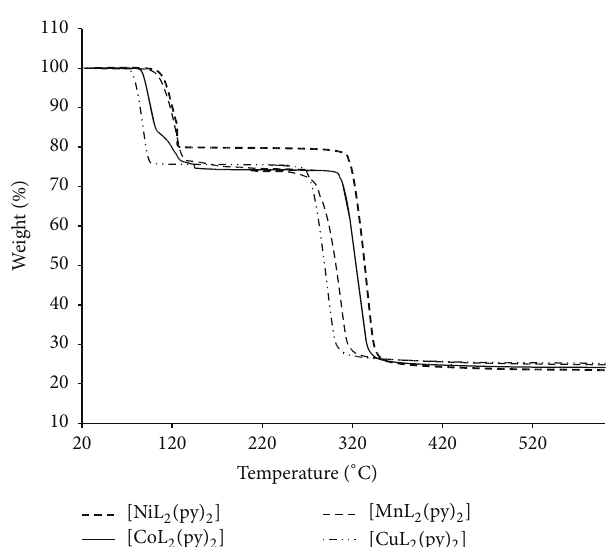
Figure 1: TGA graphs of the compounds under nitrogen flow.